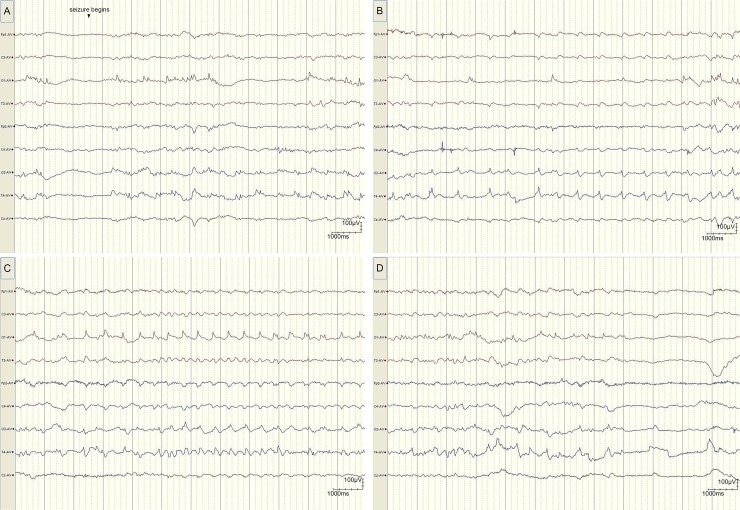
A typical time course of seizure evolution process at day 6 (patient number 21).“Seizure begins” indicated the initiation of seizure. A(0-12s of seizure) displayed a typical seizure which originated from occipital and temporal lobe(O1,O2,T4); spikes evolved into shape waves rhythm with broad base emphasized on the right hemisphere (B, 18-29s of seizure, O2,T4); Left hemisphere get involved mainly on the occipital lobe (C, 30-41s of seizure,O1); seizure ended with temporary voltage depression (D, 45-56s of seizure).